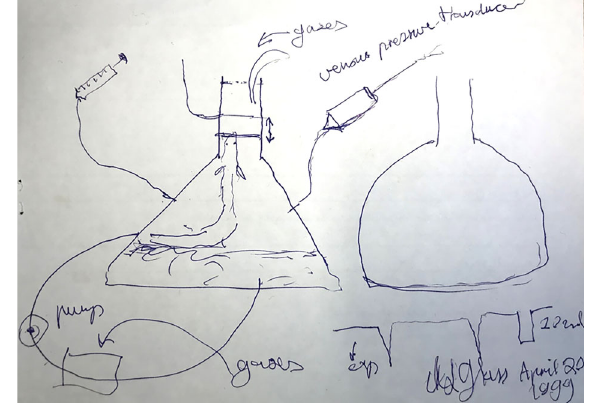
Figure 3. A ‘‘ back-of-the-envelope ’’ drawing by Mogens Glass from April 20, 1999 on Avenida do Café in Ribeirão Preto, Brazil. The fi gure depicts the set-up used to measure ventilation in aquatic snakes for his Master ’ s thesis. Here it is used for lung fi sh in a study on ventilatory responses to hypoxia (Sanchez et al.,